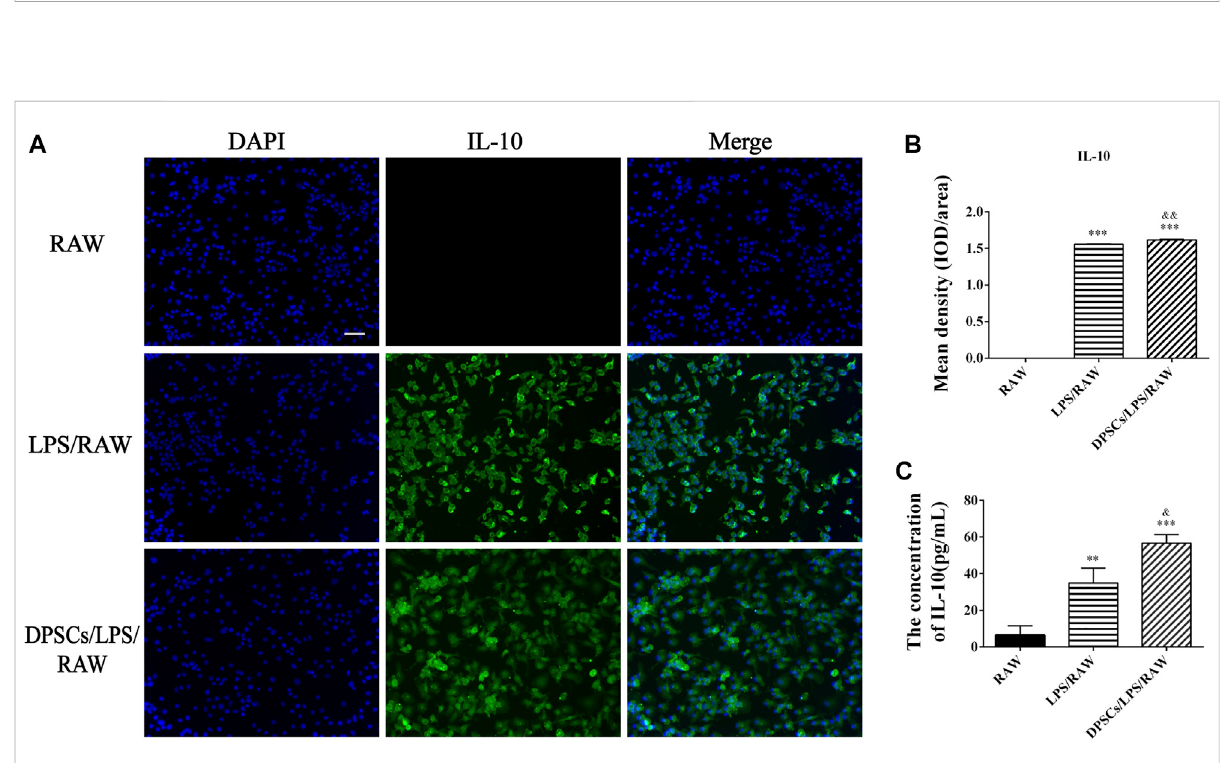
FIGURE 2 The expression of IL-10 in DPSCs co-cultured with RAW264.7 cells in vitro . (A) Immuno fl uorescence staining of IL-10. Scale bar: 50 μ m. (B) Quanti fi cation of the fl uorescence intensity of IL-10. *** p < .001 versus the RAW group. && p < .01 versus the LPS/RAW group. (C) Comparison of the supernatants IL-10 concentration among the groups. ** p < .01, *** p < .001 versus the RAW group. & p < .05 versus the LPS/RAW